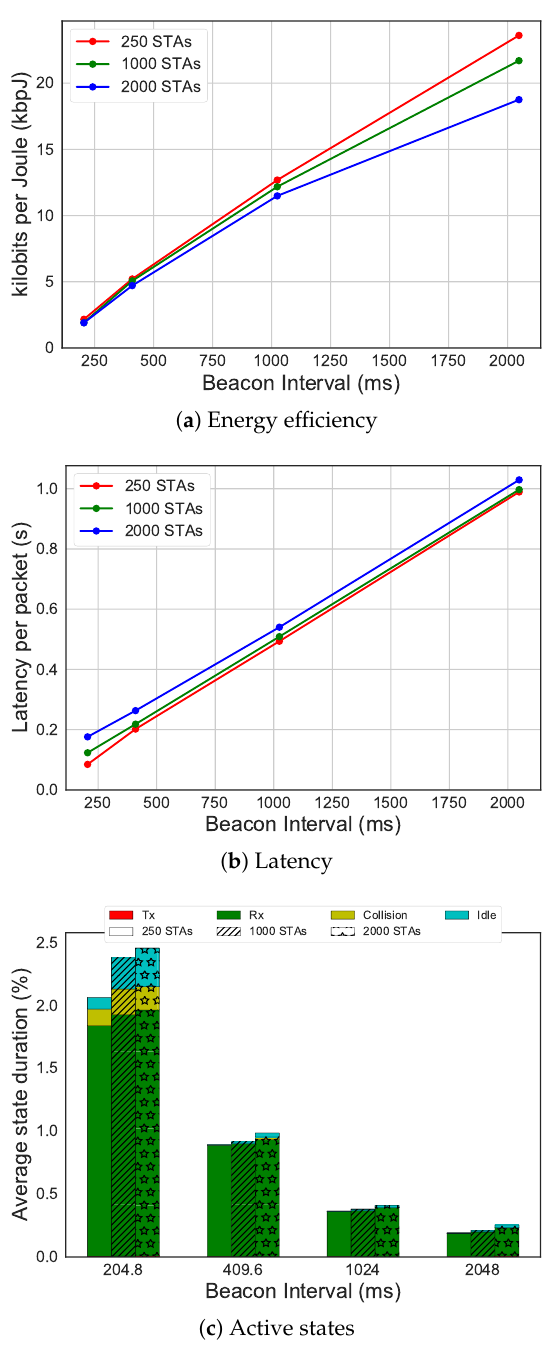
Figure 14. Energy efficiency and latency comparing different beacon intervals, using 16 bytes of payload size, average packet arrival interval of 30 s, 10 RAW groups and five slots per